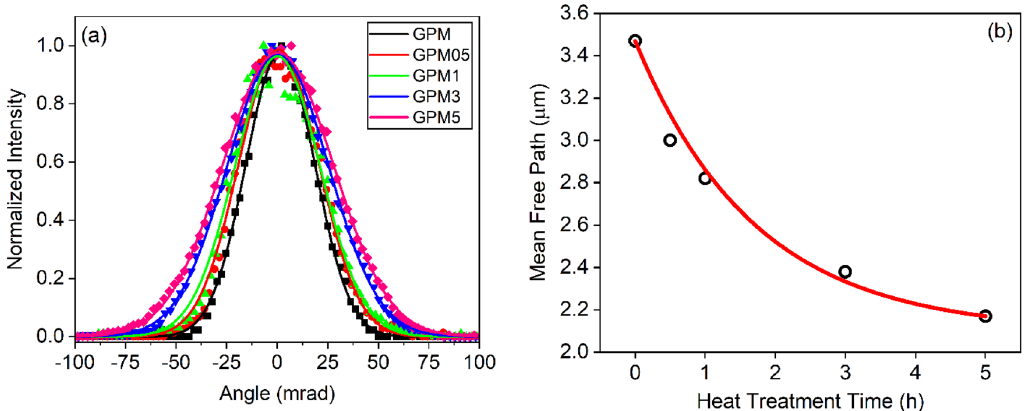
Figure 4. ( a ) CBS cones of scattered light intensity (at 1064 nm) as a function of detection angles for all samples prepared. ( b ) Mean-free-path as a function of annealing time.